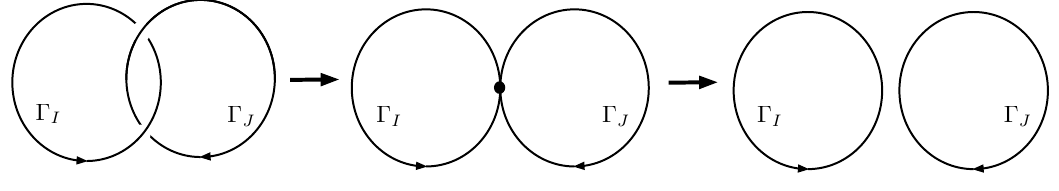
Figure 5 . When we try to separate (cid:0) I and (cid:0) J , they cross at a point as in the middle